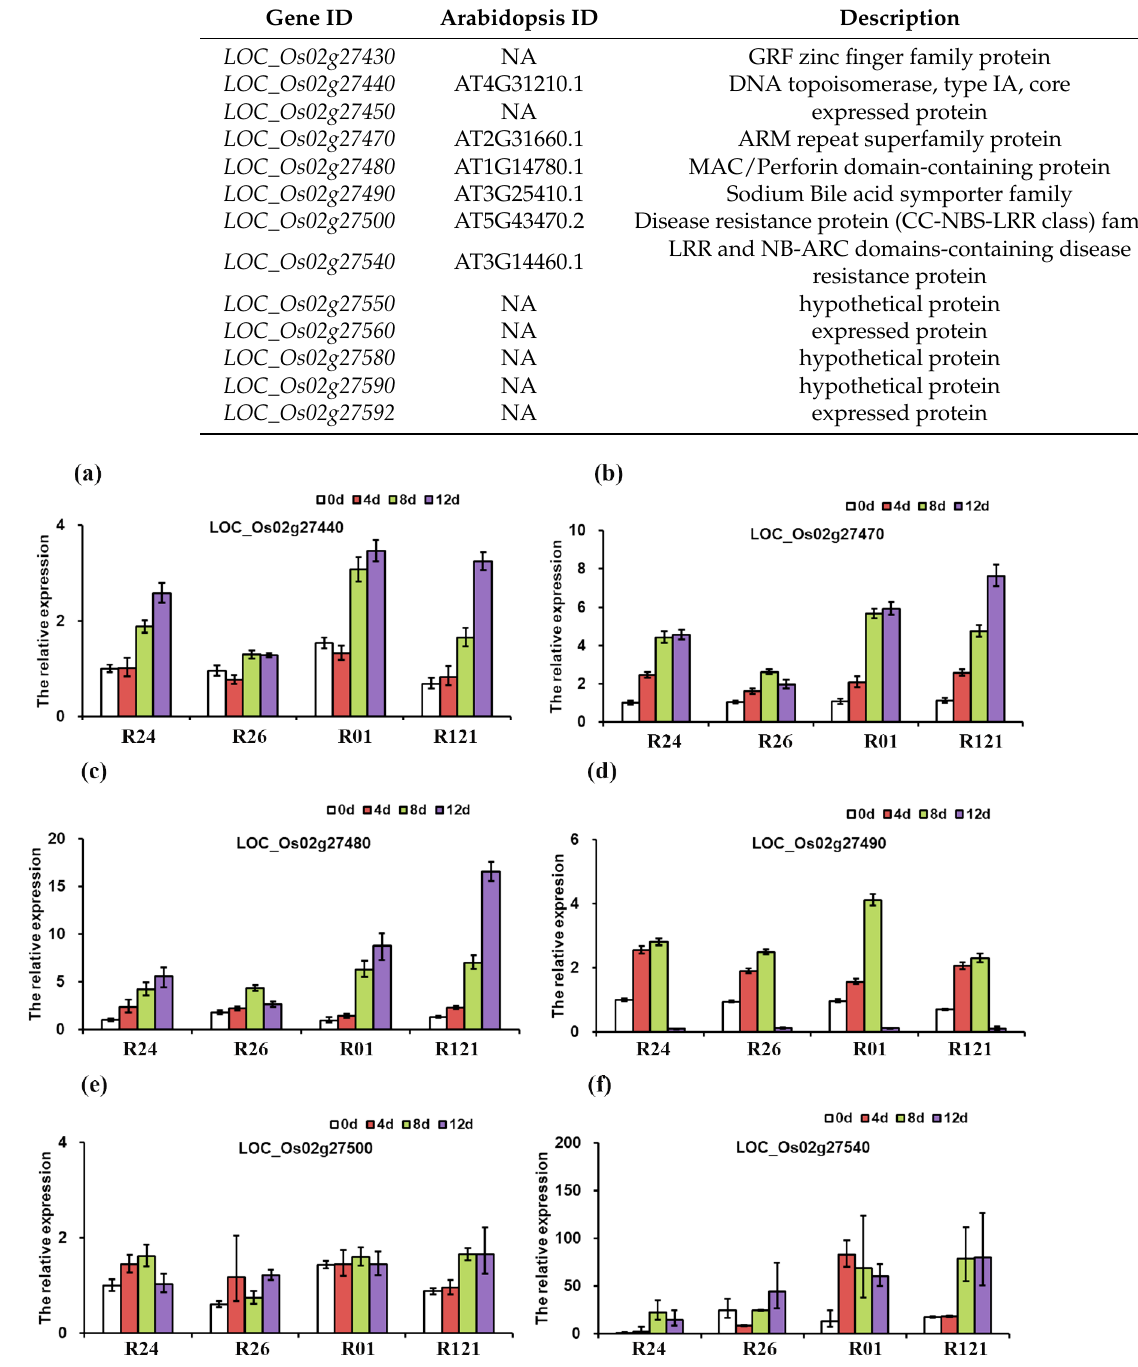
Figure 5. The gene expression changes of six candidate genes after BPH inoculation by qRT-PCR , namely, LOC_Os02g27440 ( a ), LOC_Os02g27470 ( b ), LOC_Os02g27480 ( c ), LOC_Os02g27490 ( d ), LOC_Os02g27500 ( e ), and LOC_Os02g27540 ( f ).